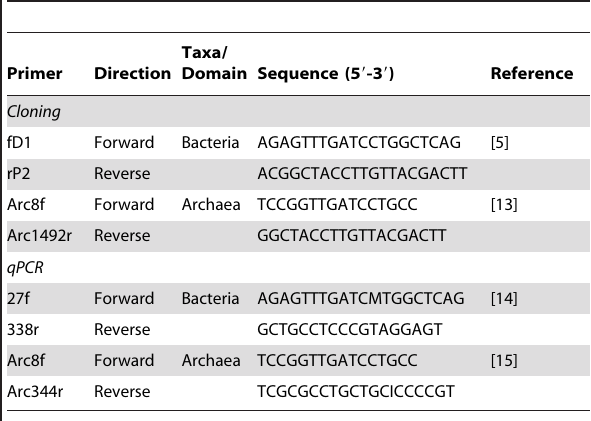
Table 1. List of primers used to amplify the 16S rRNA